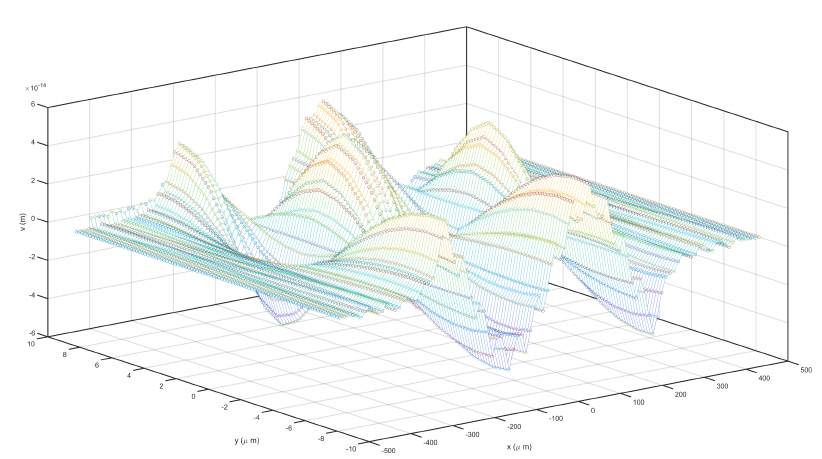
Figure 15. Vertical displacement of mode